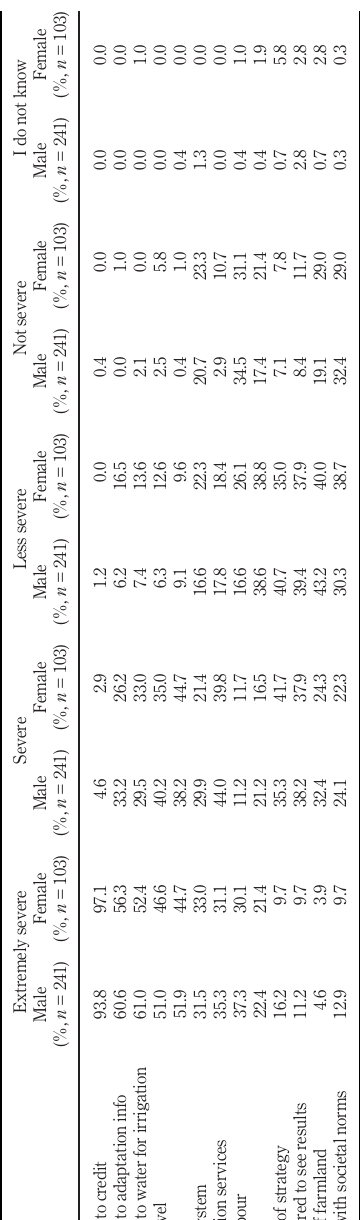
Table 3. The severity of constraints to the adaptation of farmers to climate change in the Pra River